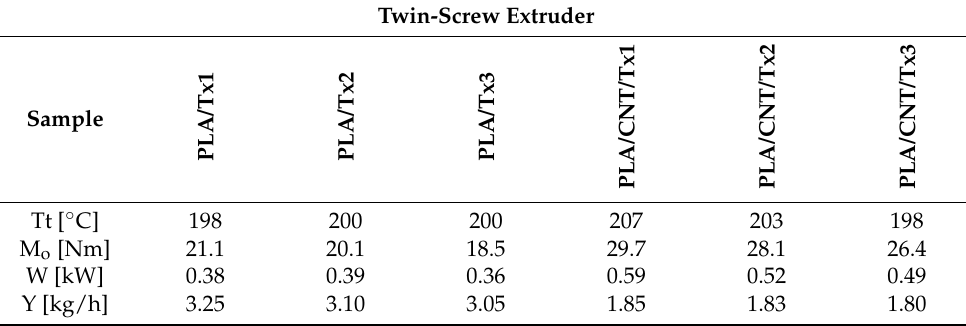
Table 3. Parameters recorded during extrusion—twin-screw extruder.